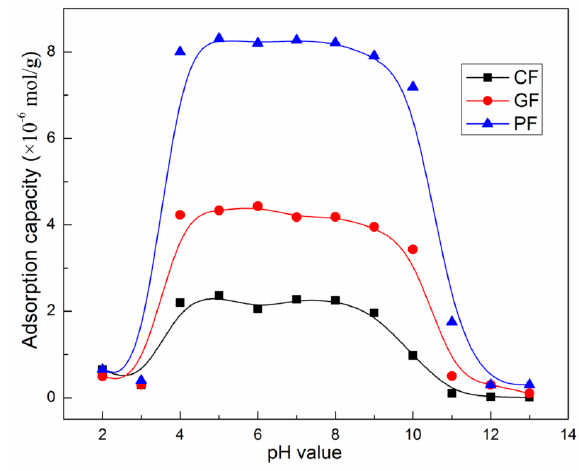
Figure 5. Adsorption capacity of NaOL on the fluorite surface as a function of pH.